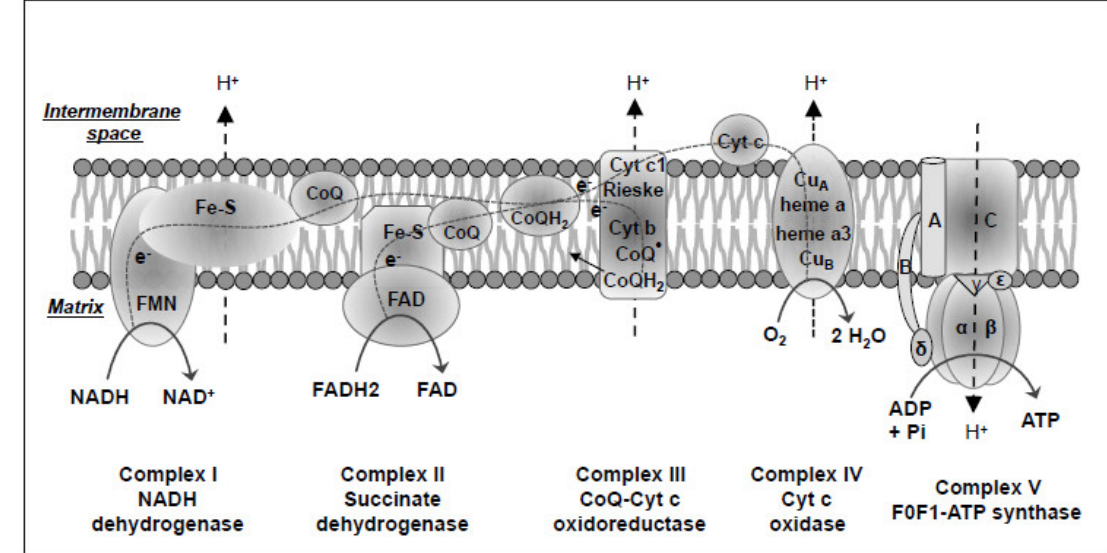
Figure 3. Schematic of mitochondrial electron transport chain and oxidative phosphorylation system. In mammalian cell mitochondria, the oxidative phosphorylation system (OXPHOS) is located largely across the inner membrane and on the side of the matrix and is organized into five multi-enzyme complexes, including complex I (also called NADH dehydrogenase), complex II (Succinate dehydrogenase), complex III (cytochrome bc1 complex or CoQ-Cyt c oxidoreductase), complex IV or cyt c oxidase (CO), and complex V (FoF1-ATP synthase) for oxidative phosphorylation and energy transfer to ATP. The high-energy electron carriers NADH and FADH2 produced by the intermediate substrate metabolism in the TCA cycle in the matrix are sequentially oxidized by Complex I and II to generate an electrochemical proton gradient across the inner membrane, which is eventually used as a driving force by the Complex V to produce ATP. FMN, flavin mononucleotide. Fe-S, iron-sulfur cluster at enzyme center. e-, a high-energy electron of negative charge. CoQ, ubiquinone or coenzyme Q. CoQH2, reduced coenzyme Q or ubiquinol. Cyt, cytochrome. CuA, cupper-containing metallic center A of complex IV. Heme a, heme-containing cytochrome a. A, B, C, α, β, γ, δ, and ε, different protein subunits of complex V. Pi, inorganic phosphate ion.